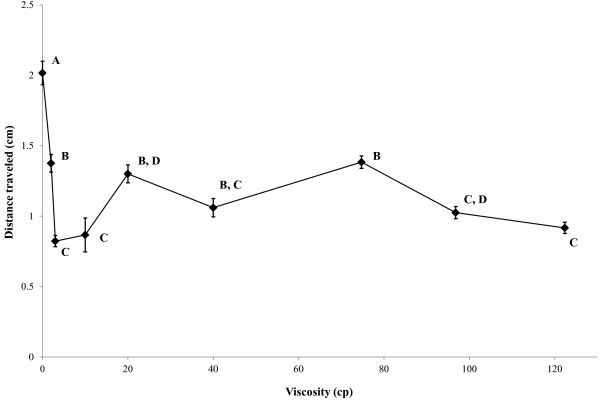
Motility of Campylobacter concisus UNSWCD following growth in liquid medium of varying viscosities. Vertical lines associated with histogram bars represent the standard error of the mean. Results were analysed using a one-way ANOVA test. In addition, tukey’s post hoc multiple comparisons test was conducted to ascertain statistically significant differences. Symbols sharing the same letter, are not statistically different (p>0.05) to each other.